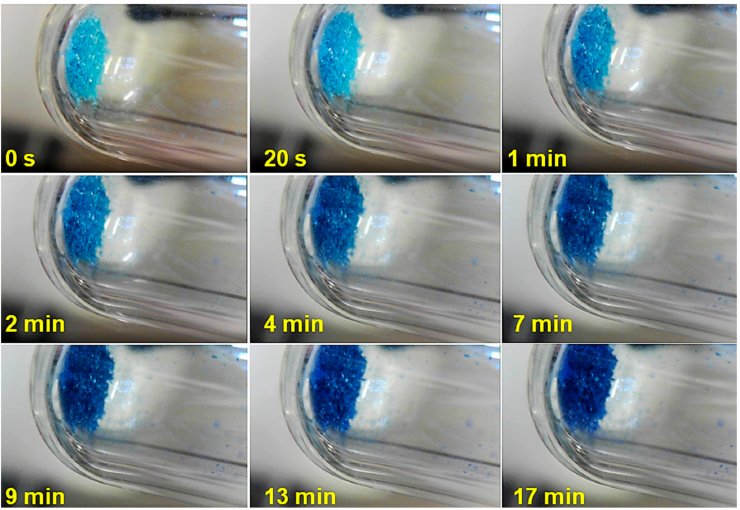
Figure 5. Sequential snapshots showing the color change of 1 under MA